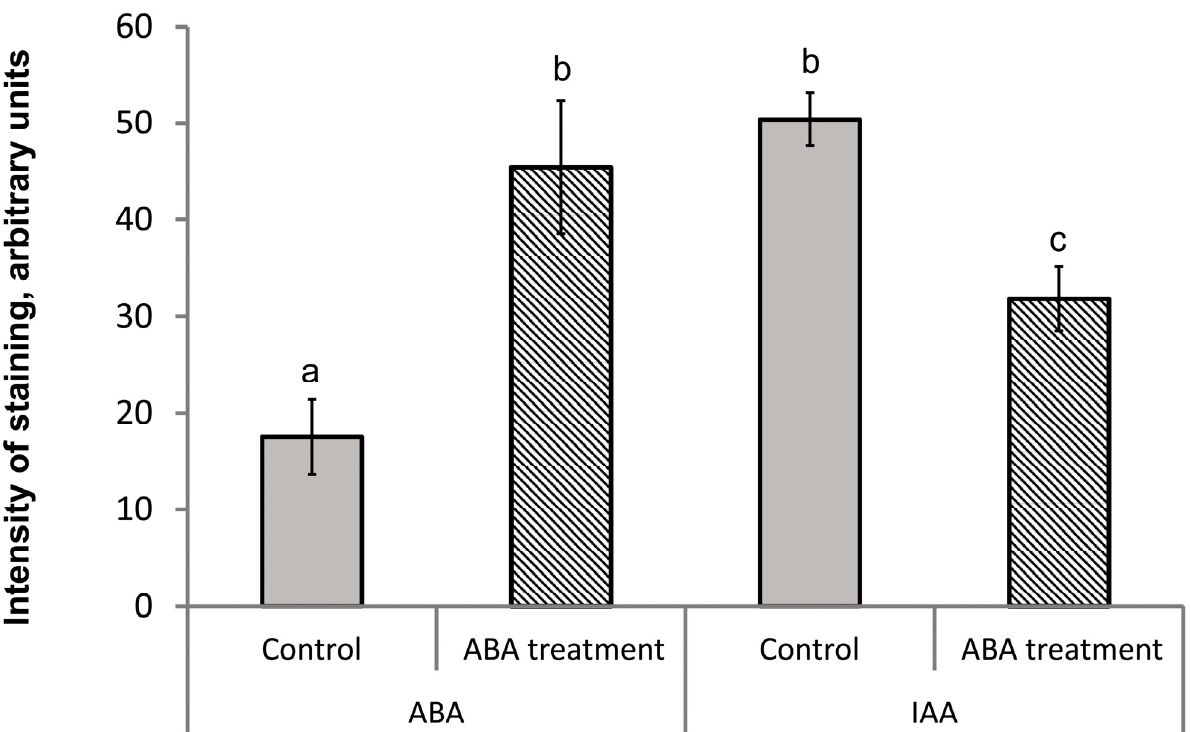
Figure 9. Intensity of immunostaining for ABA and IAA of root primordia of Az34 grown under normal conditions or under 0.1 mg/L ABA treatment. Means (arbitrary units, maximal staining taken as 100%, minimal—as 0%). Significant differences are marked with different letters. Values are means ± S.E. ( n = 25) ( p ≤ 0.05, t-test).